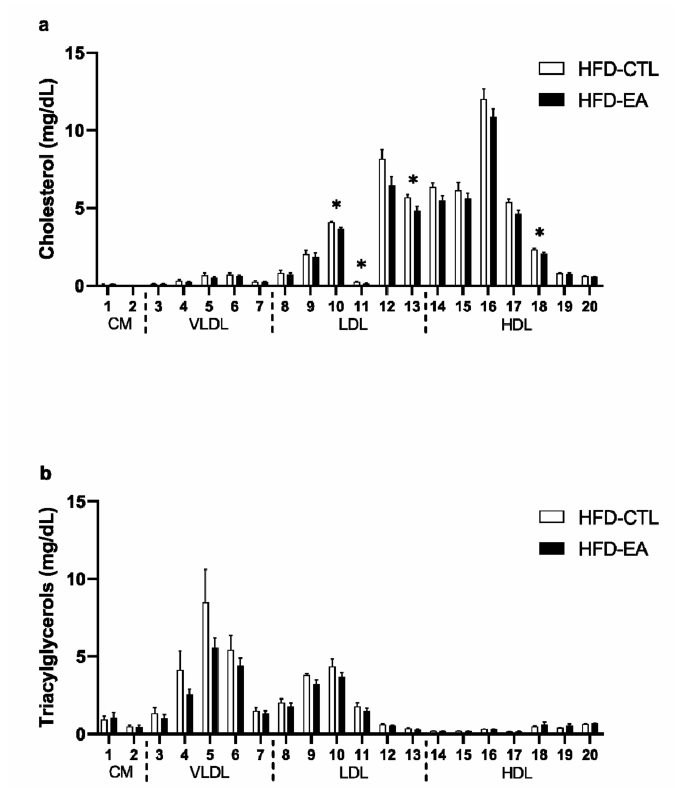
Figure 2. Effect of ellagic acid supplementation on cholesterol and triacylglycerol profile: ( a ) choles- terol and ( b ) triacylglycerols content in 20 lipoprotein subfractions in control (HFD-CTL; high-fat diet-fed rats) and experimental (HFD-EA; high-fat diet-fed rats supplemented with ellagic acid) groups of rats. Values are mean ± SEM, n = 4/group. The significance levels for comparison between HFD-CTL and HFD-EA groups is indicated as follows: * p < 0.05. The allocation of individual lipoprotein subfractions to major lipoprotein classes is shown in order of particle’s decreasing size from left to right. HFD-CTL, high-fat diet-fed rats; HFD-EA, high-fat diet-fed rats supplemented with ellagic acid; CM, chylomicron; VLDL, very low-density lipoprotein; LDL, low-density lipoprotein; HDL, high-density